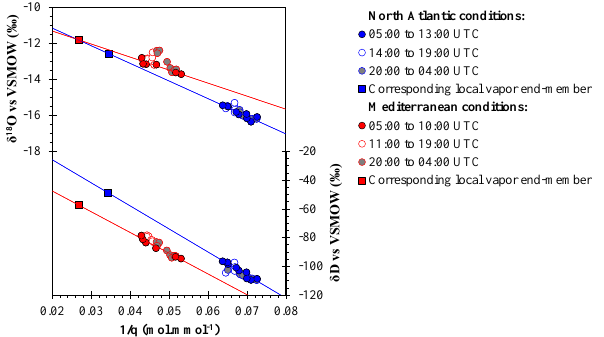
Figure 6. Relationships between hourly average values of δ v and 1 /q over a daily cycle according to the two main air mass origins, and corresponding linear regressions for the period of q increase ( δ 18 O = − 98 . 1 · ( 1 /q) − 9 . 2 ( R 2 = 0 . 84), δ D = − 1606 . 7 · ( 1 /q) + 6 . 3 ( R 2 = 0 . 93) for North Atlantic conditions, and δ 18 O = − 72 . 4 · ( 1 /q) − 9 . 9 ( R 2 = 0 . 89), δ D = − 1444 . 8 · ( 1 /q) − 18 . 7 ( R 2 = 0 . 96) for Mediterranean conditions). Squares indicate the isotopic com- position of the local end-member ( δ E ) calculated for a mixing ratio corresponding to saturation at the water surface temperature.